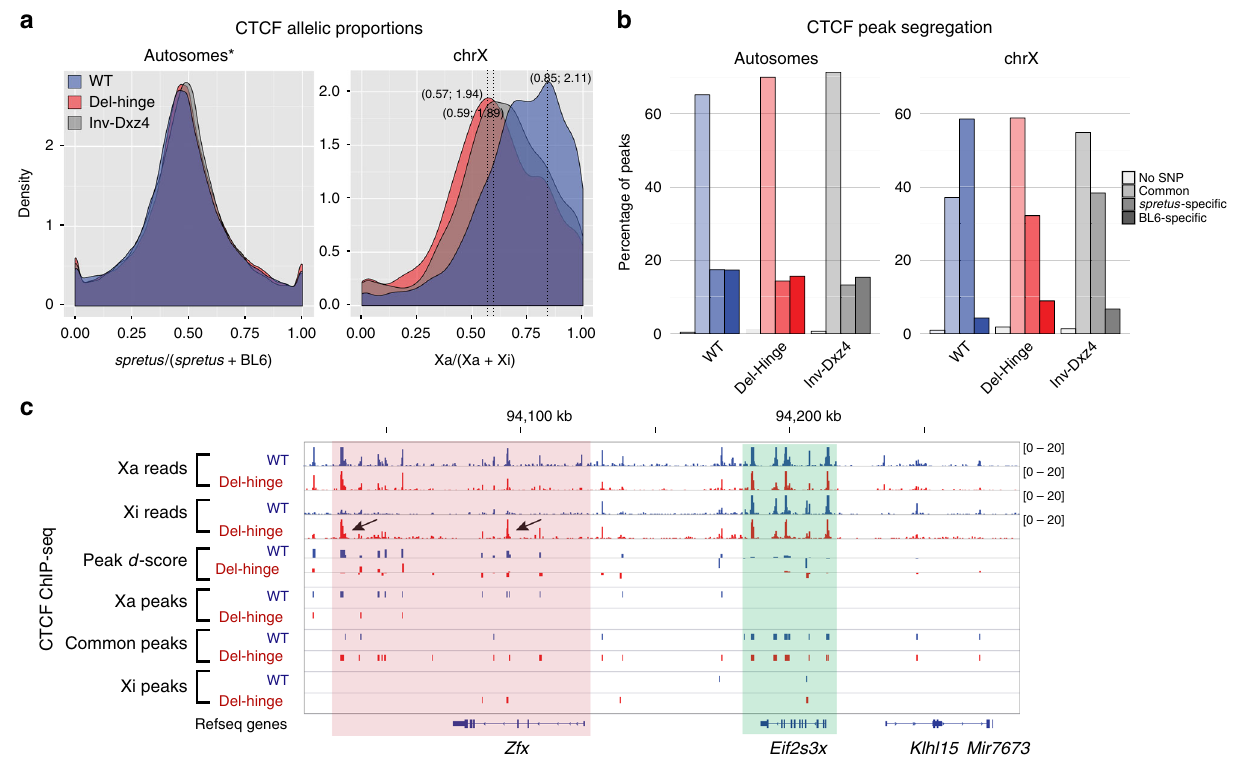
Fig. 6 CTCF peak distribution on the Xi in Del-hinge and Inv-Dxz4. a Density histograms of the distribution of allelic proportions of CTCF peaks ( spretus / ( spretus + BL6)) along autosomes and the X chromosomes for WT (blue), Del-hinge (red), and Inv-Dxz4 (gray). The modes of the X-chromosome distributions are given in parentheses. *Chromosomes 3 and 4 were removed from the autosomes because they show aneuploidy in WT (Supplementary Fig 6). A shift in the distribution of allelic proportions due to an increase in CTCF binding on the Xi is evident for the X chromosome in Del-hinge and to a lesser extent Inv-Dxz4, compared to WT. b Percentages of CTCF peaks in WT (blue), Del-hinge (red), and Inv-Dxz4 along the autosomes and the X chromosomes classi fi ed as spretus -speci fi c, BL6-speci fi c, or common peaks. c Genome browser tracks of allelic CTCF ChIP-seq reads on the Xa and Xi, of CTCF peak d -scores ((Xa/(Xa + Xi) − 0.5), and of CTCF peaks assigned as Xa-speci fi c, common, or Xi-speci fi c for WT (blue), Del-hinge (red), and Inv- Dxz4 along a region of the X chromosome (pink background) that includes Zfx (a gene subject to XCI in WT, which reactivated in Del-hinge) and a region (green background) that includes Eif2s3x (a gene that escapes XCI). CTCF peaks that appear on the Xi in a region around Zfx in Del-hinge are indicated with arrows. See additional analyses in Supplementary Fig. 5 –